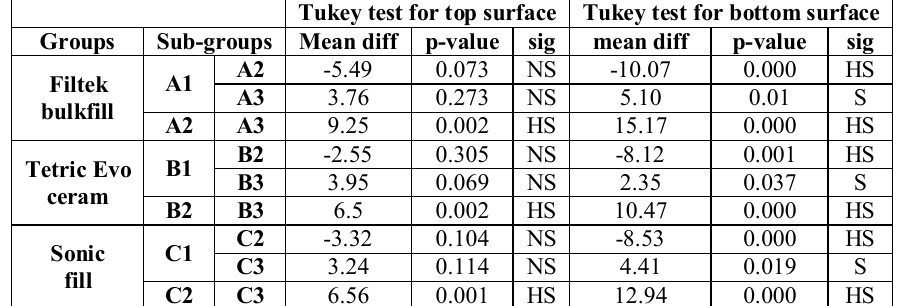
group Descriptive & ANOVA Descriptive & ANOVA for bottom for top surface surface